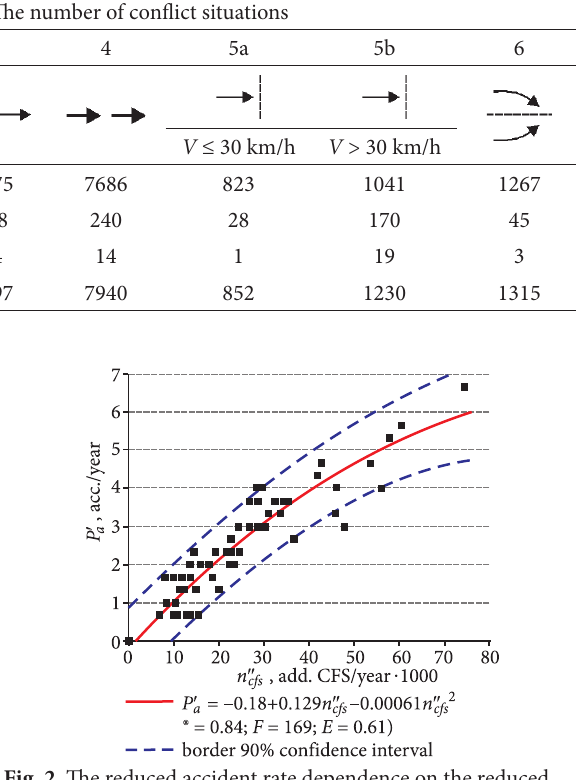
Fig. 2. The reduced accident rate dependence on the reduced conflict situations (conflict No. 1, the advanced method)